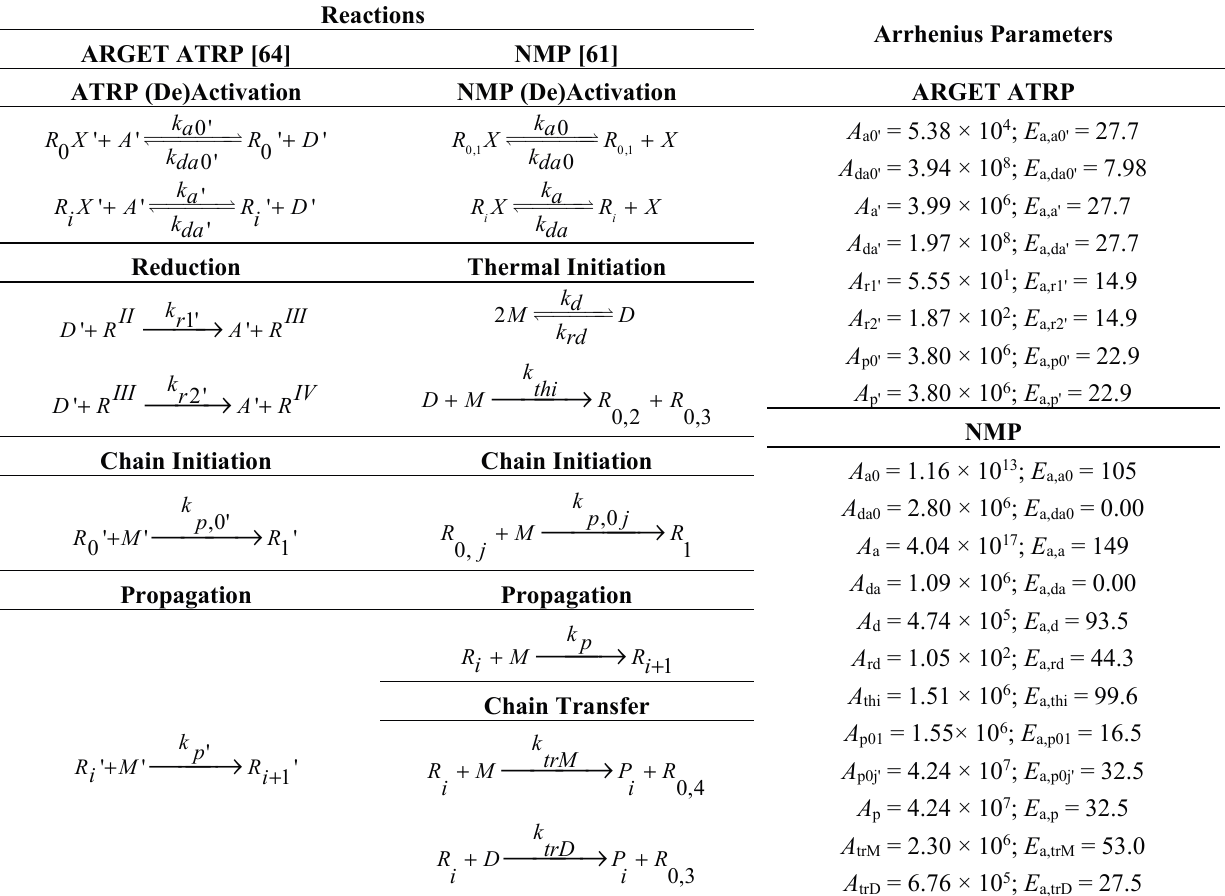
A ' = Cu I X/L, D ' = Cu II X 2 /L, R z = Sn z (EH) 2 , M ' = butyl methacrylate, R 0 X ' = ethyl